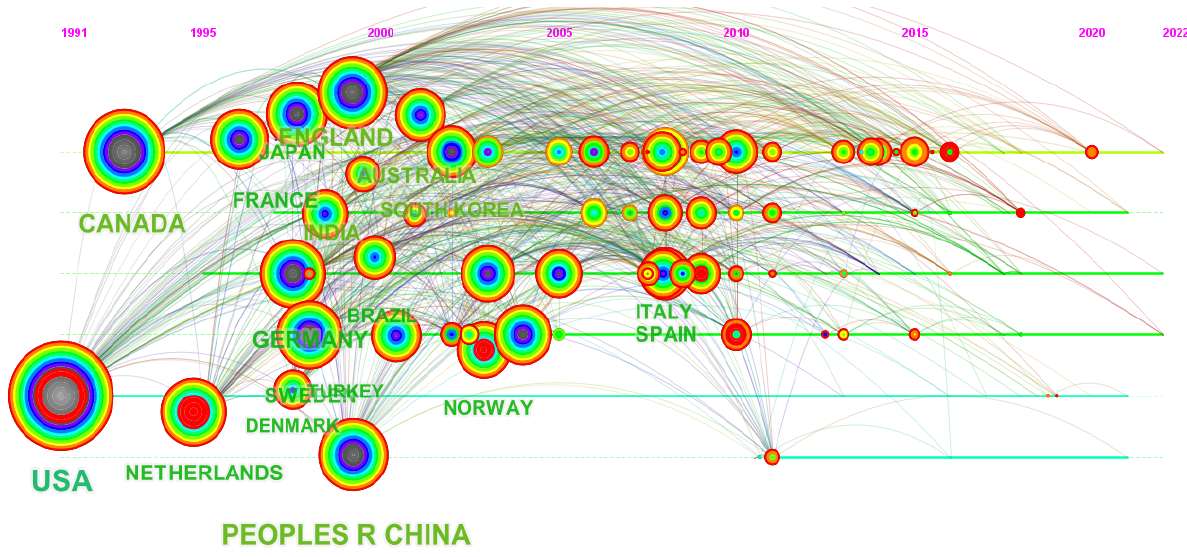
Figure 2. Country/region collaboration network: a timeline view. Table 2. Top 10 countries/regions based on the number of publications .